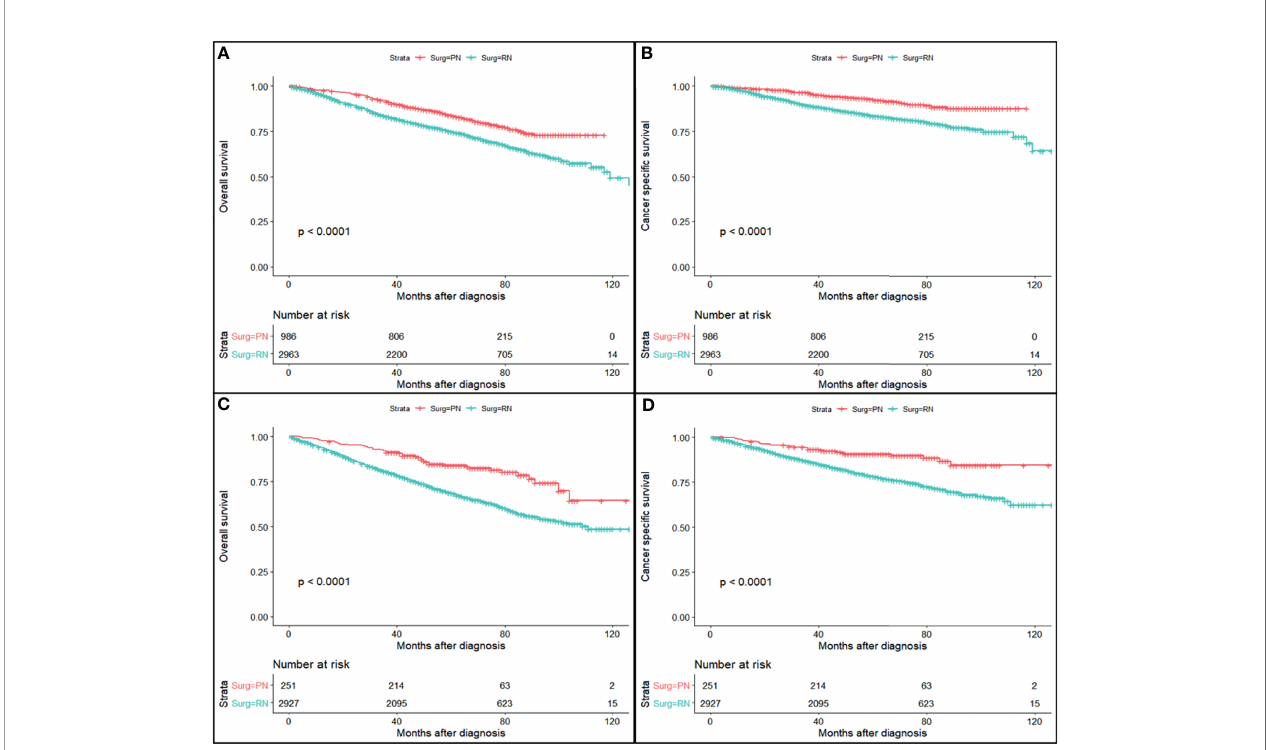
FIGURE 3 | Survival curve of partial nephrectomy (PN) and radical nephrectomy (RN) group in fat invasion cohort and venous invasion cohort before propensity score matching (PSM). (A) Overall survival (OS) curve of fat invasion cohort. (B) Cause-speci fi c survival (CSS) curve of fat invasion cohort. (C) OS curve of venous invasion cohort. (D) CSS curve of venous invasion